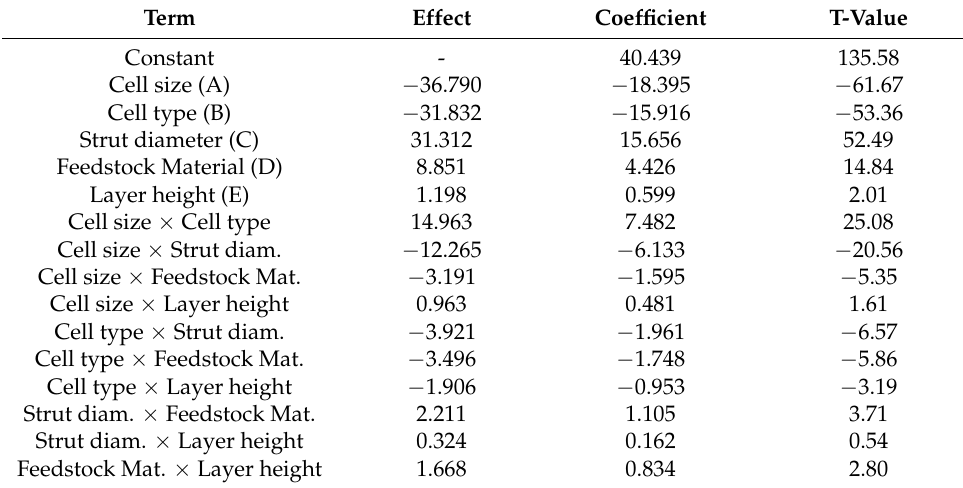
Table 7. Regression coefficients for elastic